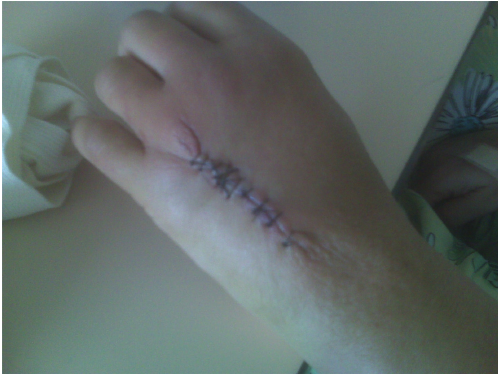
Figure 3: Patient’s left hand following surgical